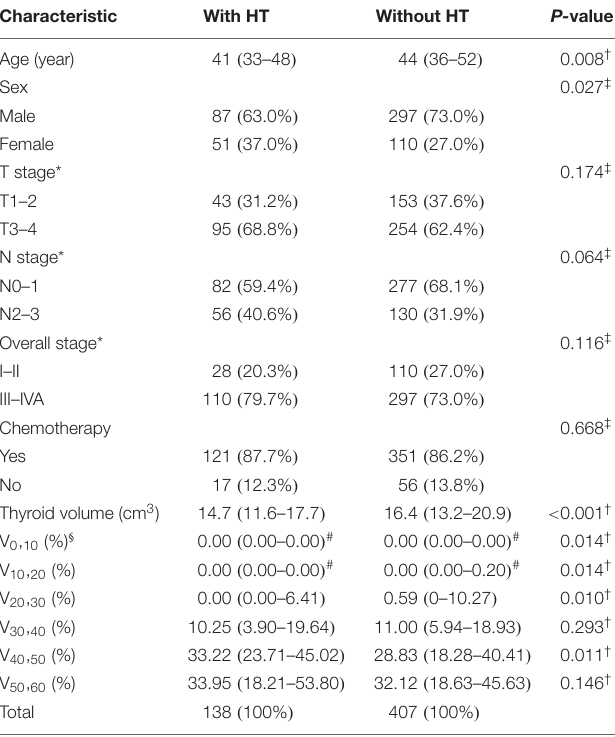
TABLE 1 | Clinical and dosimetry characteristics in patients with and without HT.